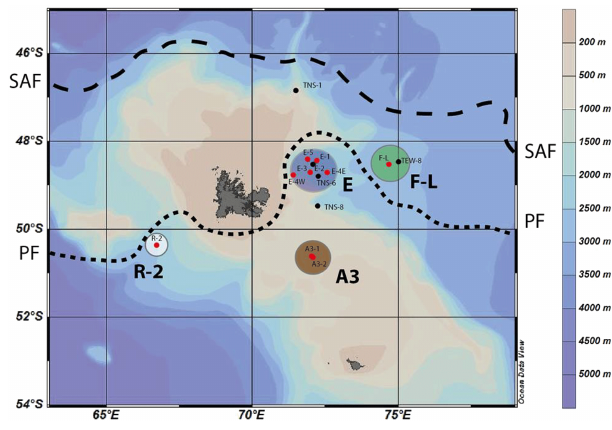
Figure 1. Stations map of 234 Th measurements during the KEOPS2 expedition. Also, shown are the positions of the subantarctic front (SAF) and the PF adapted from Park et al. (2008b). Colored circles refer to the following clusters of stations showing similar charac- teristics: Control station R-2, north of the PF station F-L, plateau station A3, and PF meander E stations (see text for